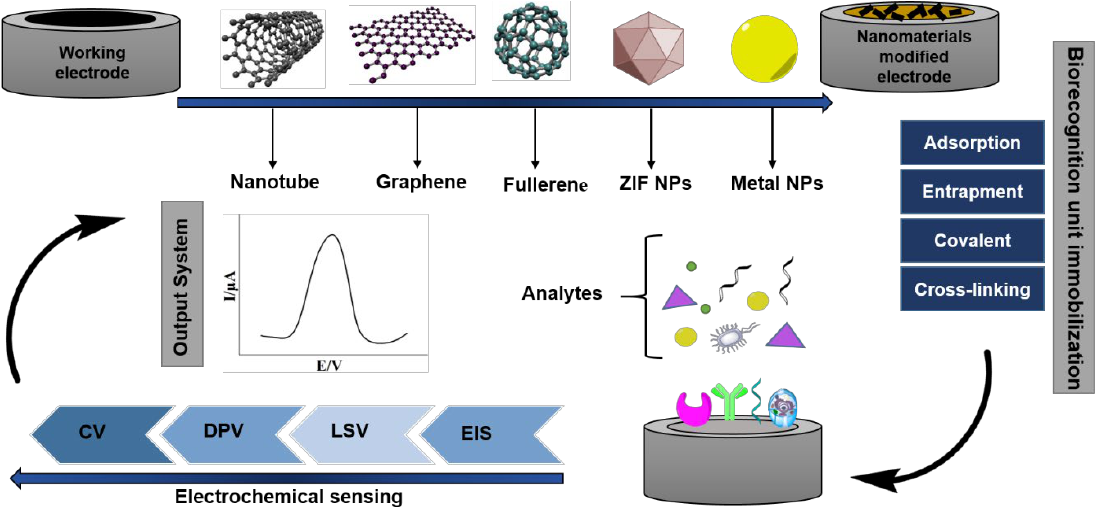
Figure Figure 1. Label-free electrochemical cancer biosensors: electrode modifications such as nanotech- nology-based materials, biorecognition immobilization protocols and some of the powerful electro- chemical detection techniques.